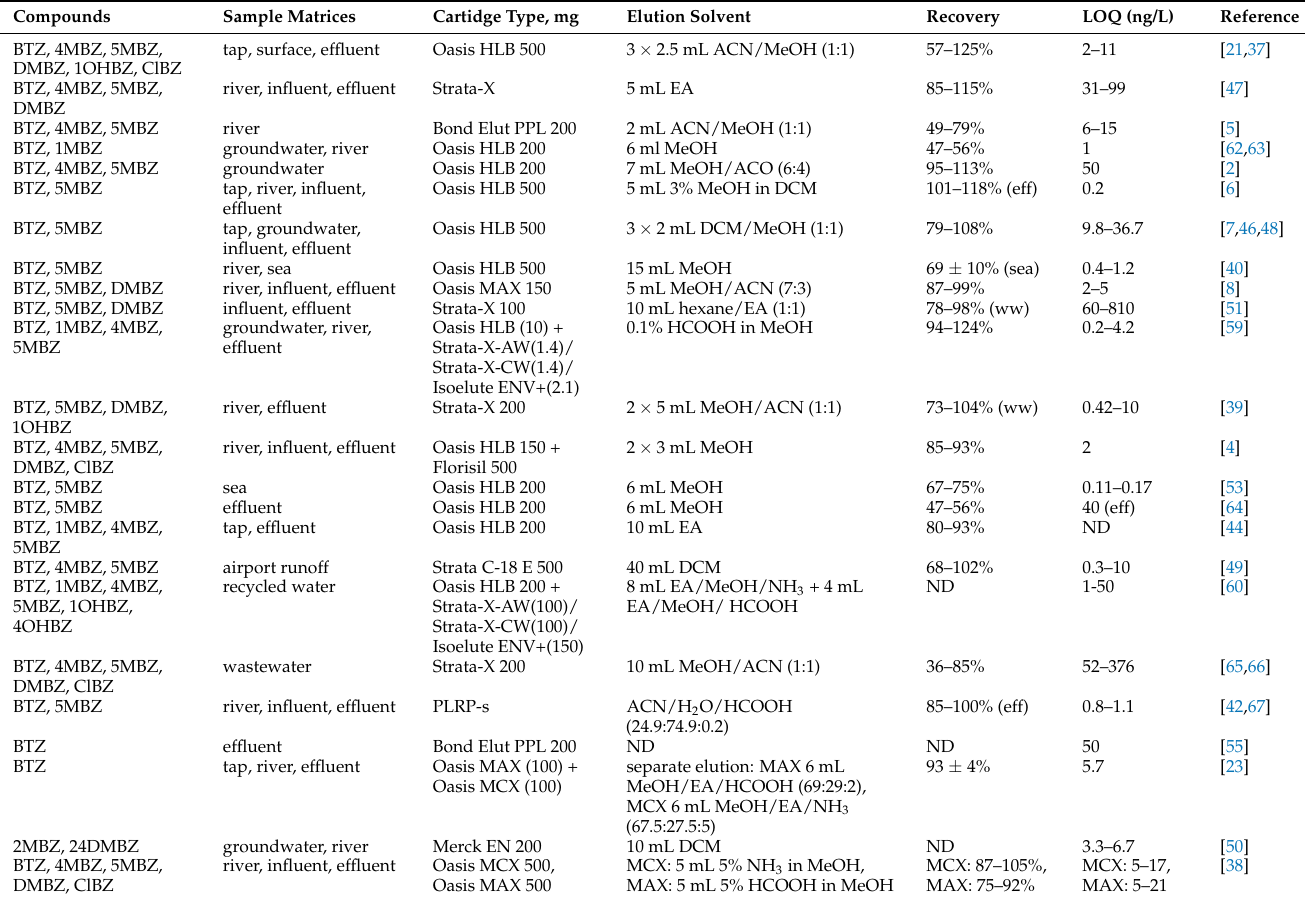
Table 2. SPE methods reported for polar benzotriazoles in aqueous environmental samples (eff–effluent, ww–wastewater, ND–no